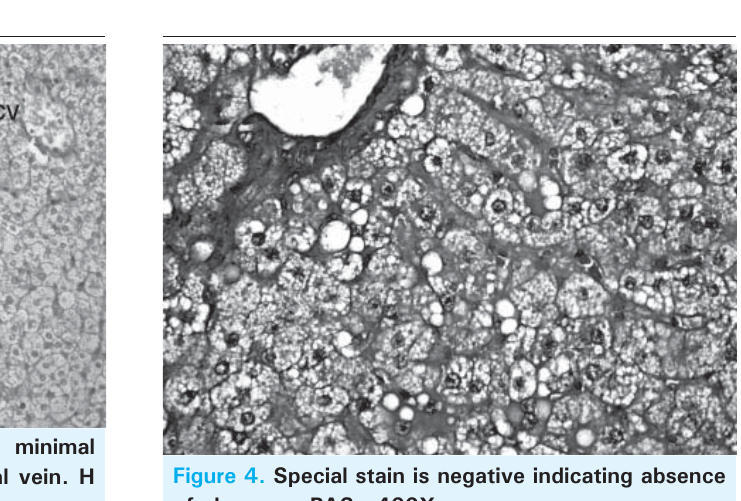
Figure 4. Special stain is negative indicating absence of glycogen. PAS.